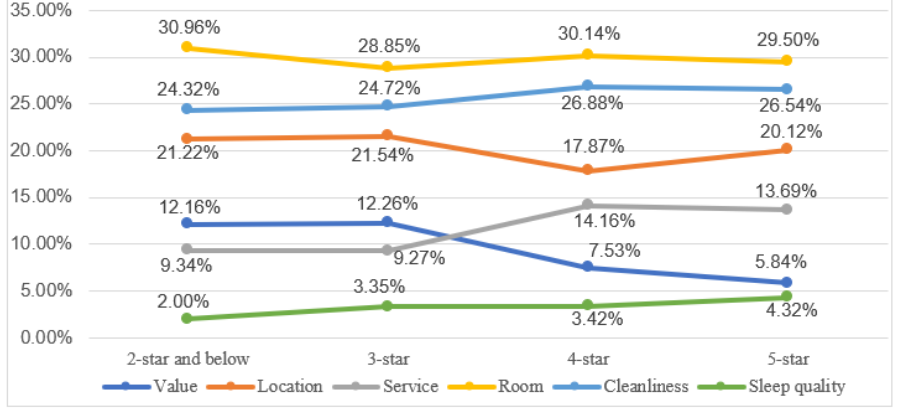
Figure 5. The percentage of negative sentiment values concerning six attributes.